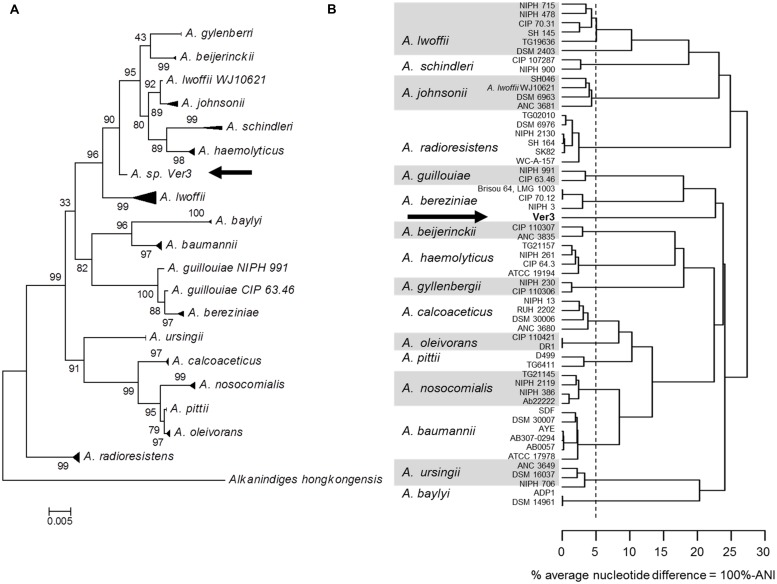
Phylogenetic analysis of 55 Acinetobacter strains. Strain Acinetobacter sp. Ver3 is indicated with an arrow. (A) Maximum likelihood tree from 16S rRNA gene. (B) Dendogram based on whole genome average nucleotide identity (ANI). The vertical dashed line represents the proposed 95% species cutoff (Goris et al., 2007).